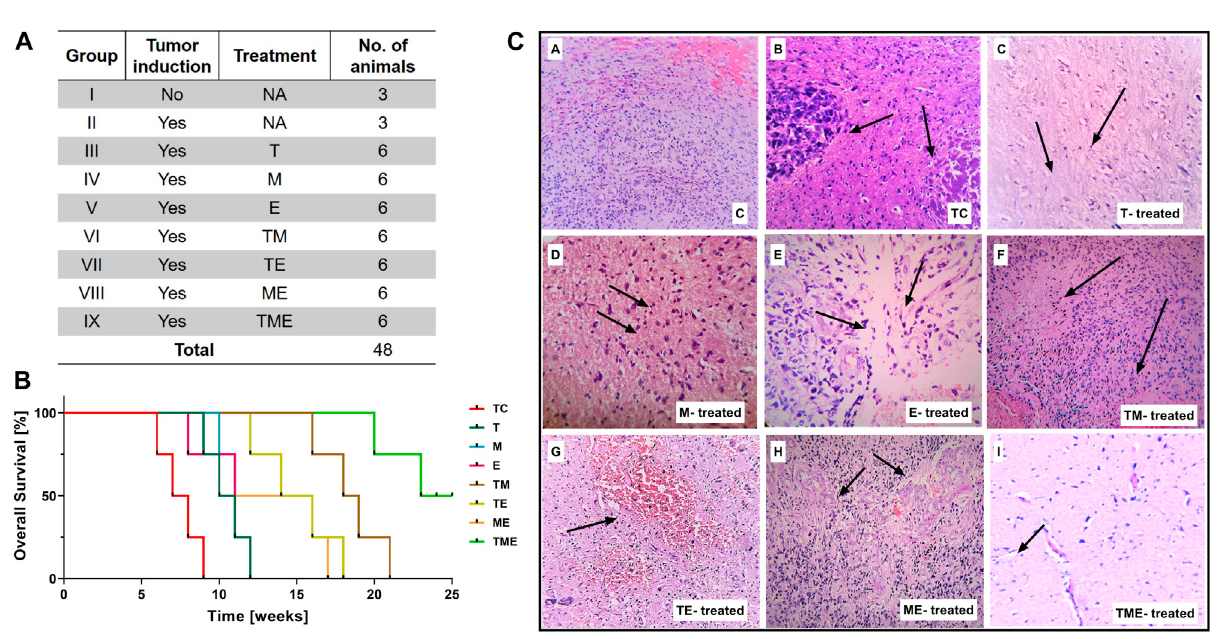
FIGURE 1 (A) Table showing the treatment strategies followed in the present study (* Survival study; # Experimental studies). (B) Kaplan-Meier survival curves were plotted and statistical analysis (Wilcoxon-Gehan test) was performed. (C) H & E staining of tumor sections from various treatment groups. Images were captured at 20x magni fi cation, wherein the images (C – a) and (C – b) correspond to (C) and TC, while (C – c) to (C – i) correspond to treatment with “ T, ” “ M, ” “ E, ” TM, TE, ME and